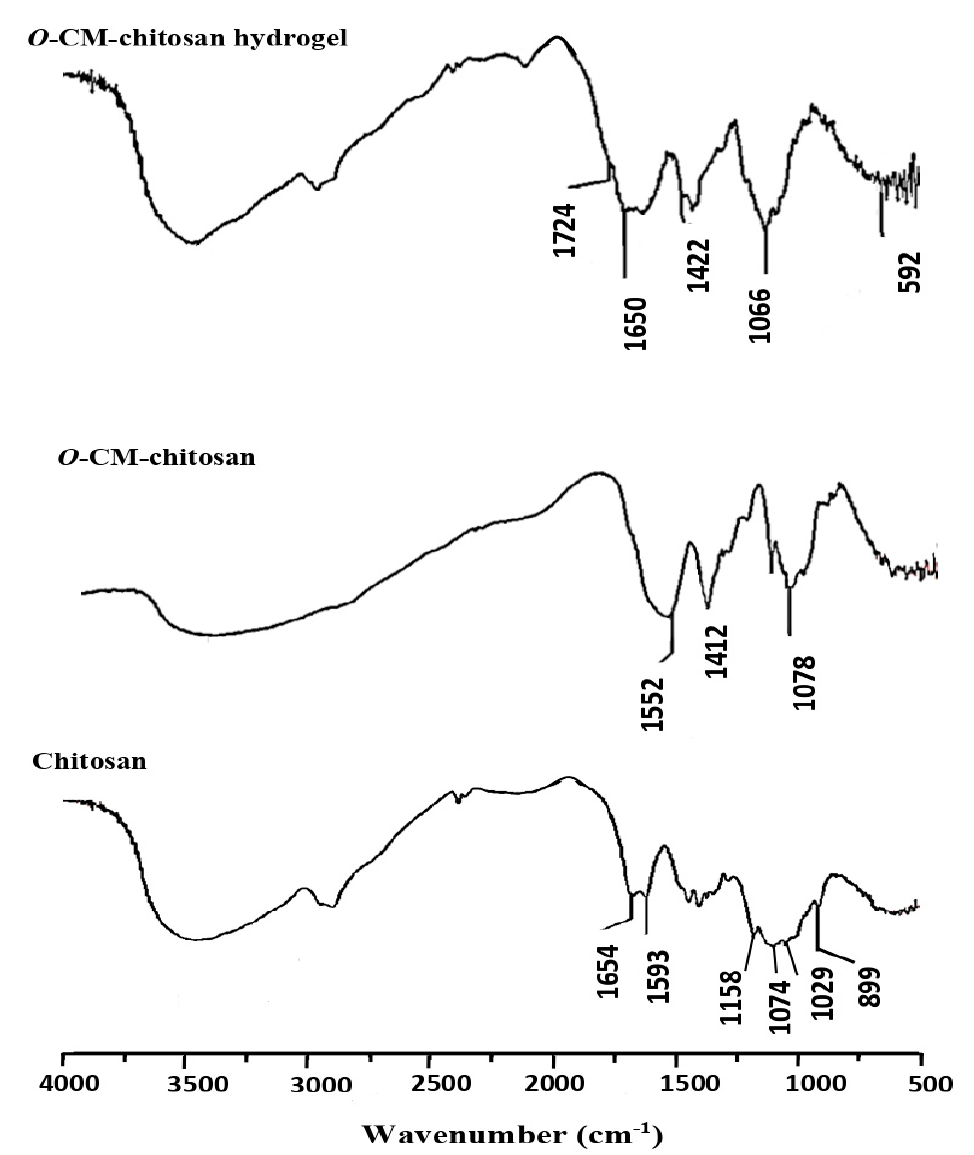
Figure 3. FTIR spectra of chitosan, O -CM-chitosan and O -CM-chitosan hydrogel.